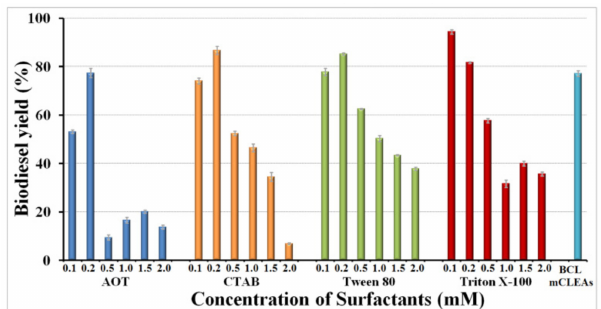
Figure 5. Four di ff erent surfactants activation on activity of surfactant-activated BCL mCLEAs in biodiesel